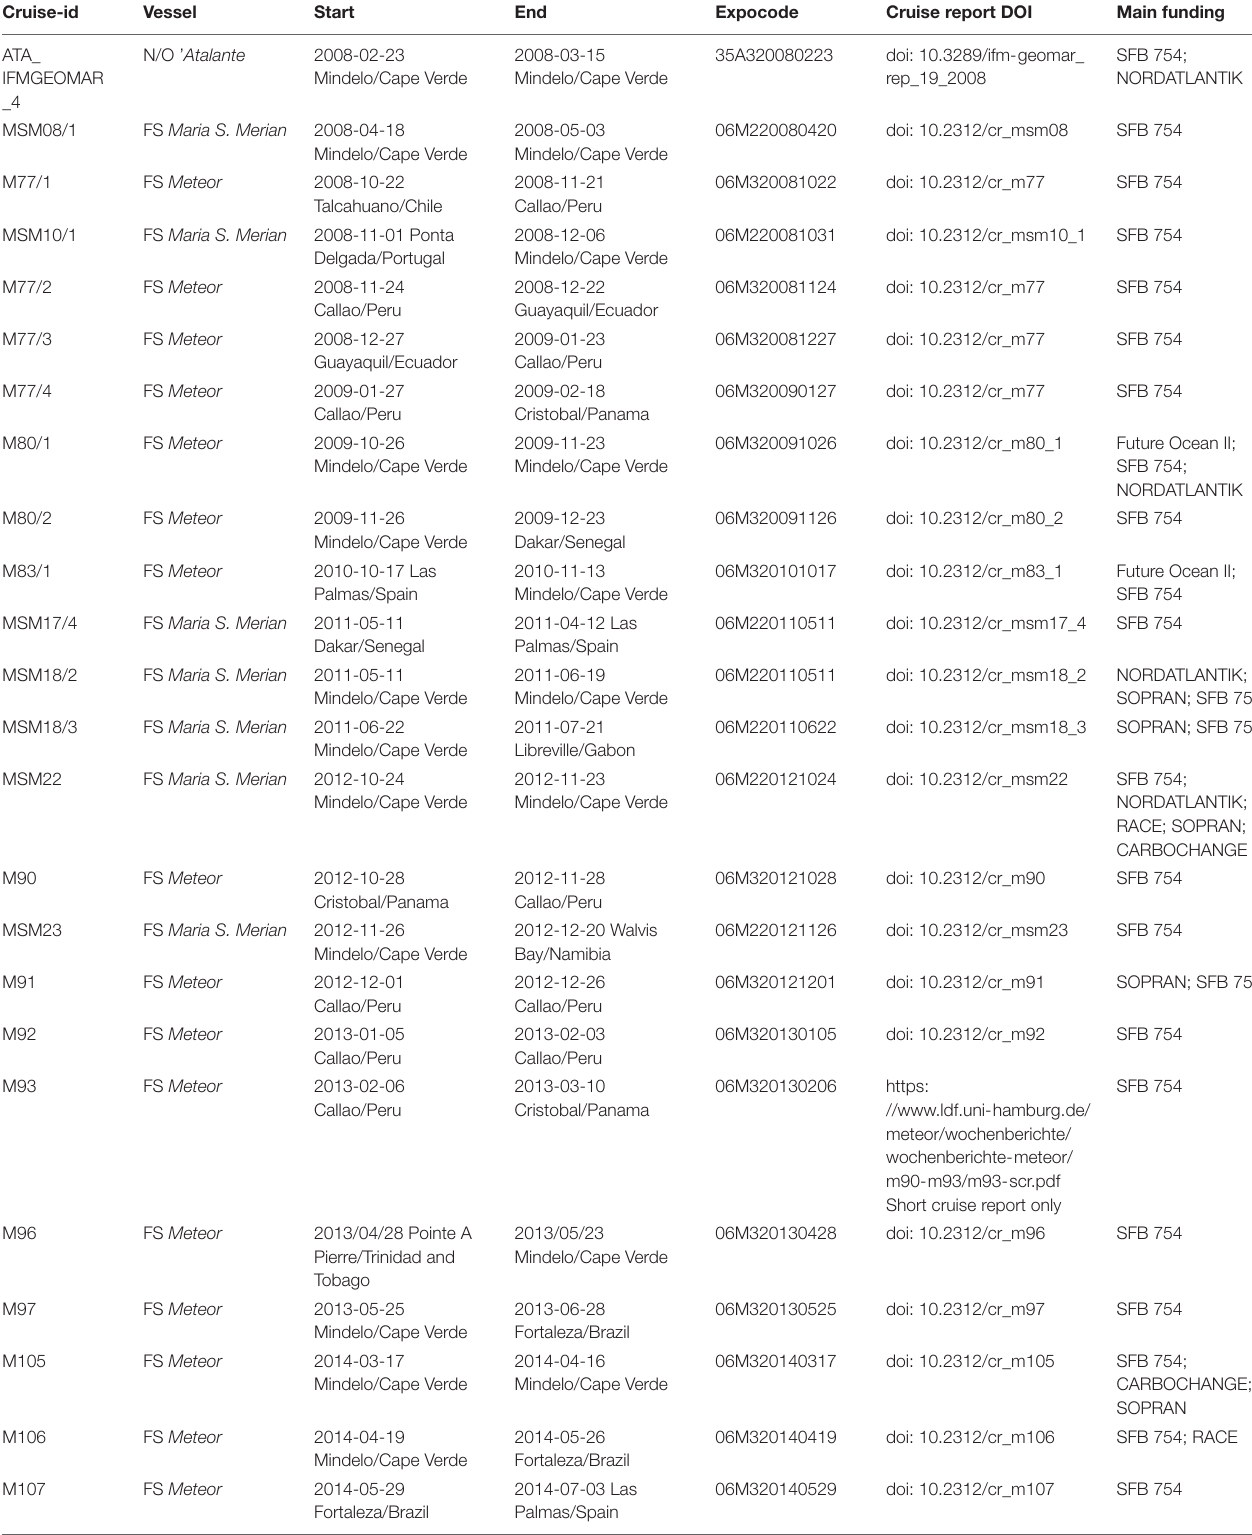
TABLE 1 | Cruises on large research vessels in chronological